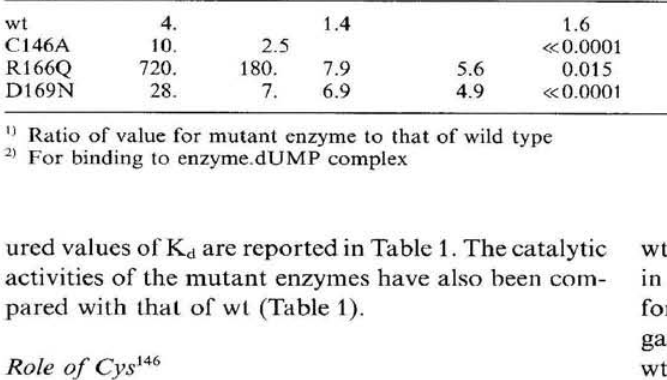
Table 1. Comparison of dissociation constants (K d ) for ligand binding and of the steady-state kinetic parameters k cat and K m s for wild type and mutant thymidylate synthases